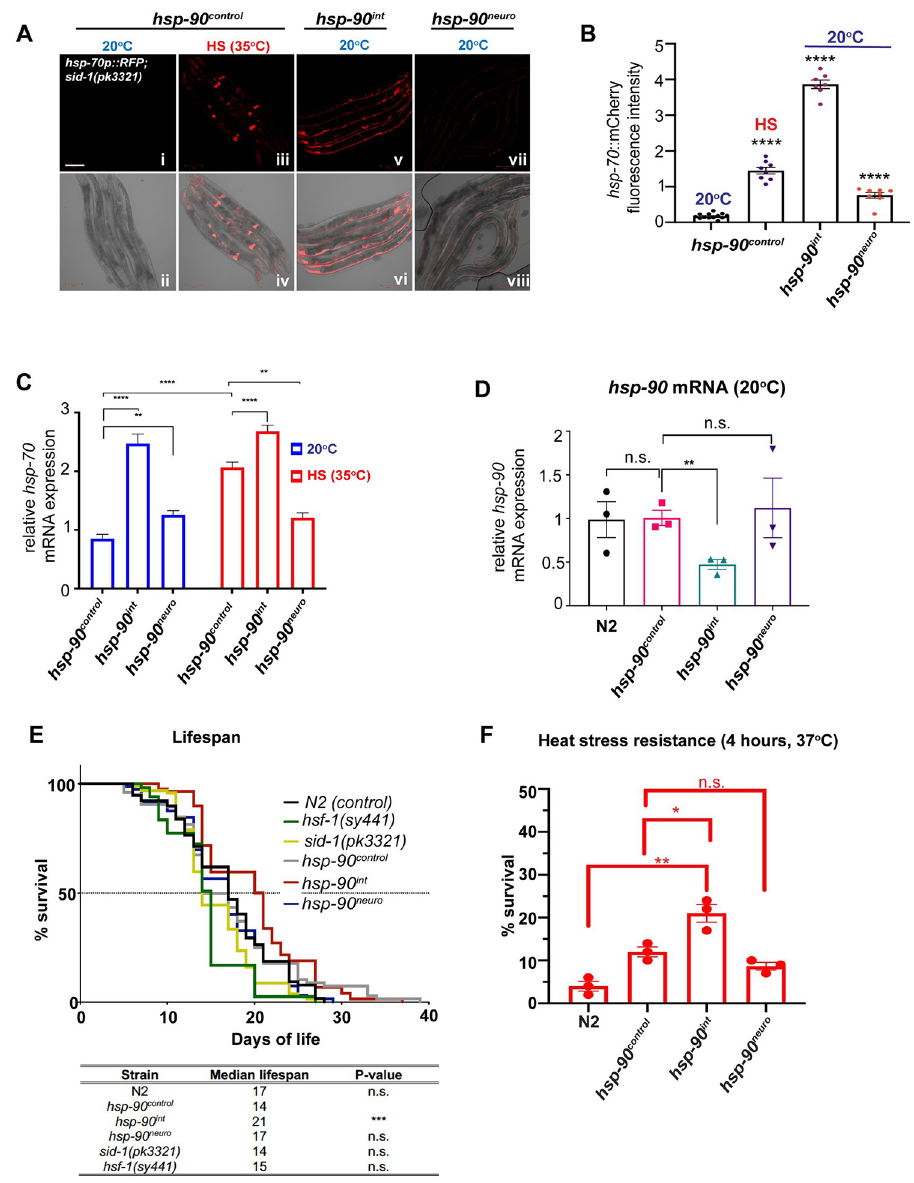
Fig 1. TCS induces hsp-70 cell nonautonomously in muscle cells and increases lifespan and stress resistance. ( A ) HS (1 h; 35˚C) induces expression of the hsp-70p :: mCherry reporter in the spermatheca and pharynx ( iii, iv ). Intestine- ( v, vi ) and neuron-specific ( vii , viii ) hsp-90 knockdown induces hsp-70p :: mCherry expression in muscle cells at 20˚C. ( B ) Quantification of hsp-70p :: mCherry fluorescence intensity induced by TCS in hsp-90 int and hsp-90 neuro compared to HS-induced hsp-70p :: mCherry expression in control animals ( hsp-90 control ). At least 5 animals per image and 3 biological replicates. Significance compared to mean fluorescence intensity in hsp-90 control was determined using one- way ANOVA. ( C ) Whole-animal hsp-70 mRNA levels of hsp-90 int and hsp-90 neuro animals compared to hsp-90 control nematodes at 20˚C and after a 1-h HS at 35˚C. ( D ) Whole-animal hsp-90 mRNA levels in hsp-90 int and hsp-90 neuro animals compared to hsp-90 control . ( C, D ) Bar graphs represent the average of 3 biological replicates of 50 animals per RNAi and/or temperature condition. Error bars represent SEM of the 3 biological replicates. The statistical significance was determined using ( C ) two-way ANOVA and ( D ) Student’s t test, relative to the control strain hsp-90 control . ( E ) Lifespan of hsp-90 int and hsp-90 neuro compared to hsp-90 control and N2 animals. hsf-1(sy441) and sid-1(pk3321) strains were used as controls. n = 100 animals per strain. Survival curves were compared using Grehan–Breslow–Wilcoxon test. ( F ) Thermotolerance following a 2- and 4-h heat shock at 37˚C. n > 3 replicates of 50 animals per strain per time point. Significance compared to hsp-90 control was determined using Student’s t test. ( B–F ) � P < 0.05; �� P < 0.01; ��� P < 0.001; ���� P < 0.0001; n.s. = not significant. Source data underlying Fig 1B–F are provided in S1 Data. HSF-1, heat shock factor 1; RNAi, RNA interference; TCS, transcellular chaperone